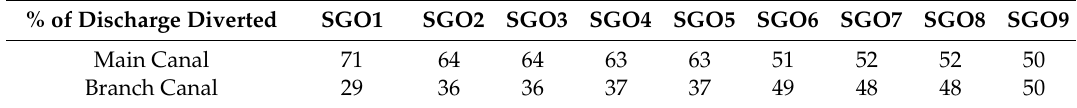
Table 5. Percentage of diverted discharge to the main and branch canals .